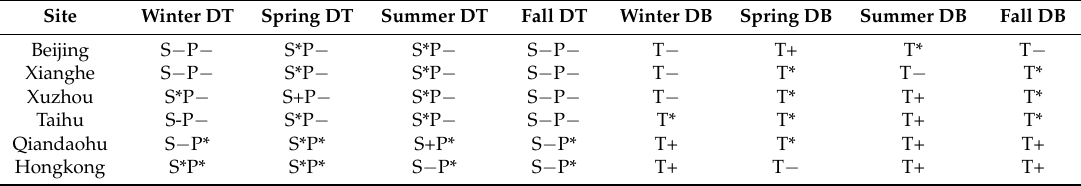
Figure 8. ( a ) Comparison of monthly mean SSA (black) and MODIS DT SSA from fine (blue for non-absorbing and red for moderately absorbing) and coarse aerosol models at 0.55 μm; ( b ) Monthly mean AERONET effective radius (μm) for total column (black), fine mode (red), and coarse mode aerosols (blue) in Beijing. Table 3. Proposed modification for aerosol models of MODIS DT and DB retrievals in eastern China. S and P denote SSA and Particle size of fine aerosol models of DT; T signifies the total scattering properties of DB aerosol models (SSA and particle size used unknown); symbols of ‘+’, ‘ − ’, and ‘*’ mean the parameter should be increased, deceased, or unchanged, respectively.